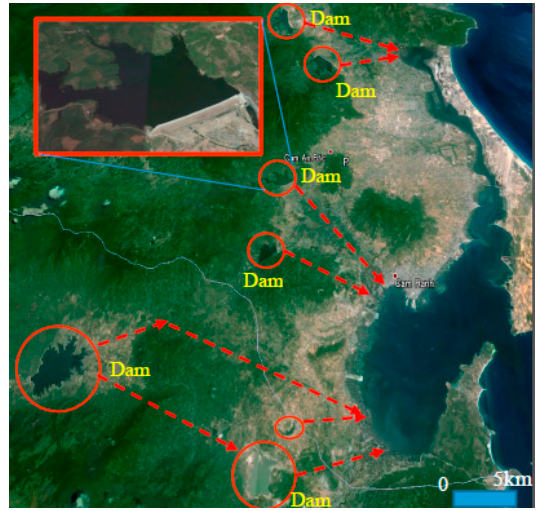
Figure 2. Dams and rivers surrounding study area (Google Earth).